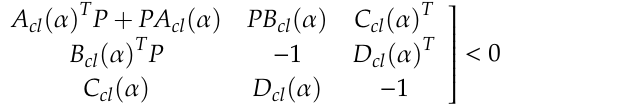
Figure 16. Step responses with the H ∞ LPV controller containing a pure integral part.